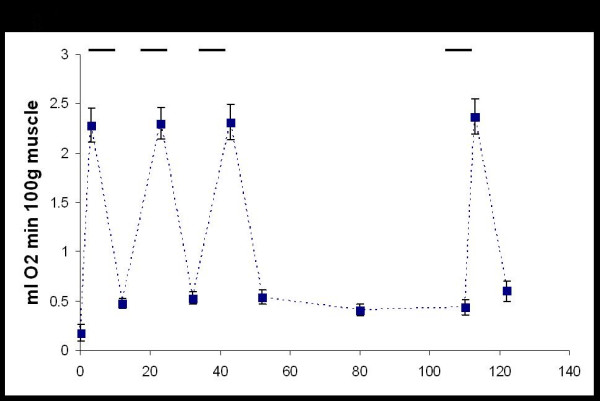
Skeletal muscle oxygen consumption measured at rest and during the 3rd to fourth minute of contraction (this is when a venous blood sample was obtained). Oxygen consumption was calculated from the arterial-venous difference (oxygen content) and muscle blood flow. Oxygen consumption during contraction did not differ across the 4 stimulation periods. The black bars at the top of the graph represent the period of muscle stimulation.